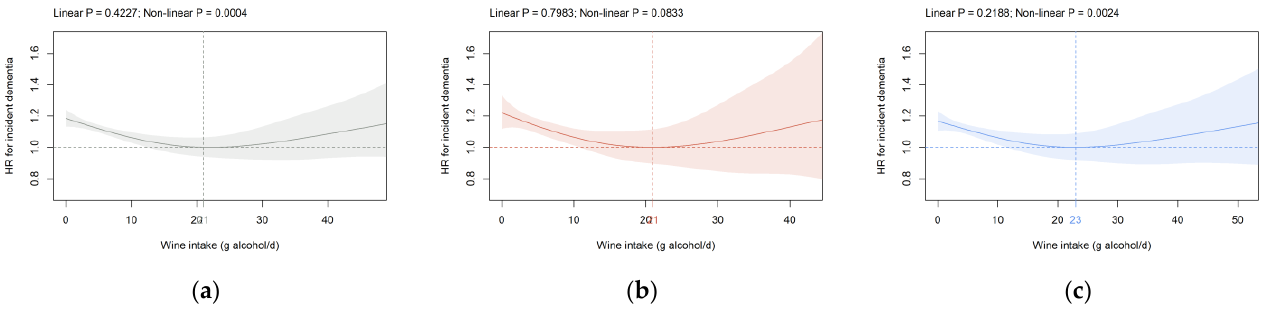
Figure 1. Association of wine intake (g alcohol/d) with dementia risk in the primary cohort in ( a ) all participants, ( b ) females, and ( c ) males. Data are adjusted for sex (all participants only), age, AHI, ethnicity, highest qualification, OHR, PA, percentage body fat, and smoking status. Wine, non-wine, coffee, and tea intake are mutually adjusted (e.g., wine intake is additionally adjusted for non-wine, coffee, and tea intake). The nadir is indicated in grey (total cohort), red (female), and blue (male). AHI: Annual household income; HR: Hazard ratio; OHR: Overall health rating; PA: Physical activ- ity. Figure 2. Association of non-wine intake (g alcohol/d) with dementia risk in the primary cohort in ( a ) all participants, ( b ) females, and ( c ) males. Data are adjusted and presented as indicated in Figure 1.